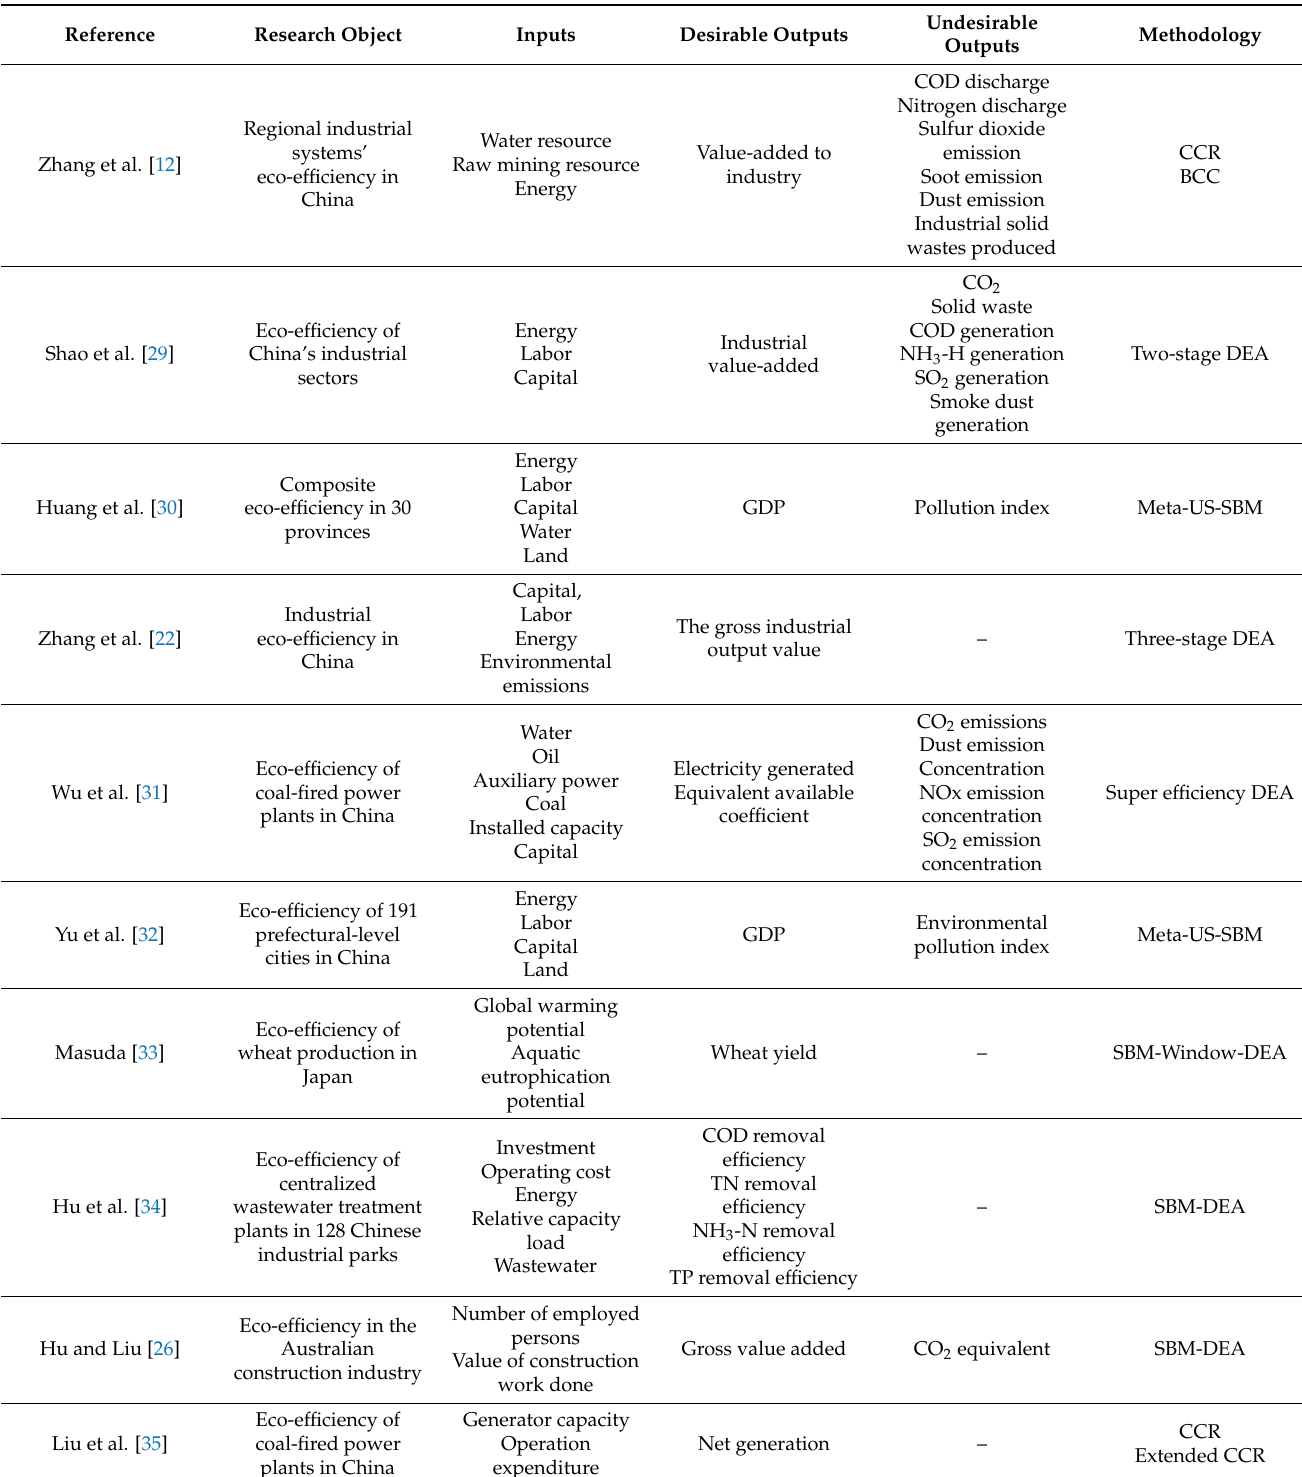
Table 1. Summary of DEA applications to